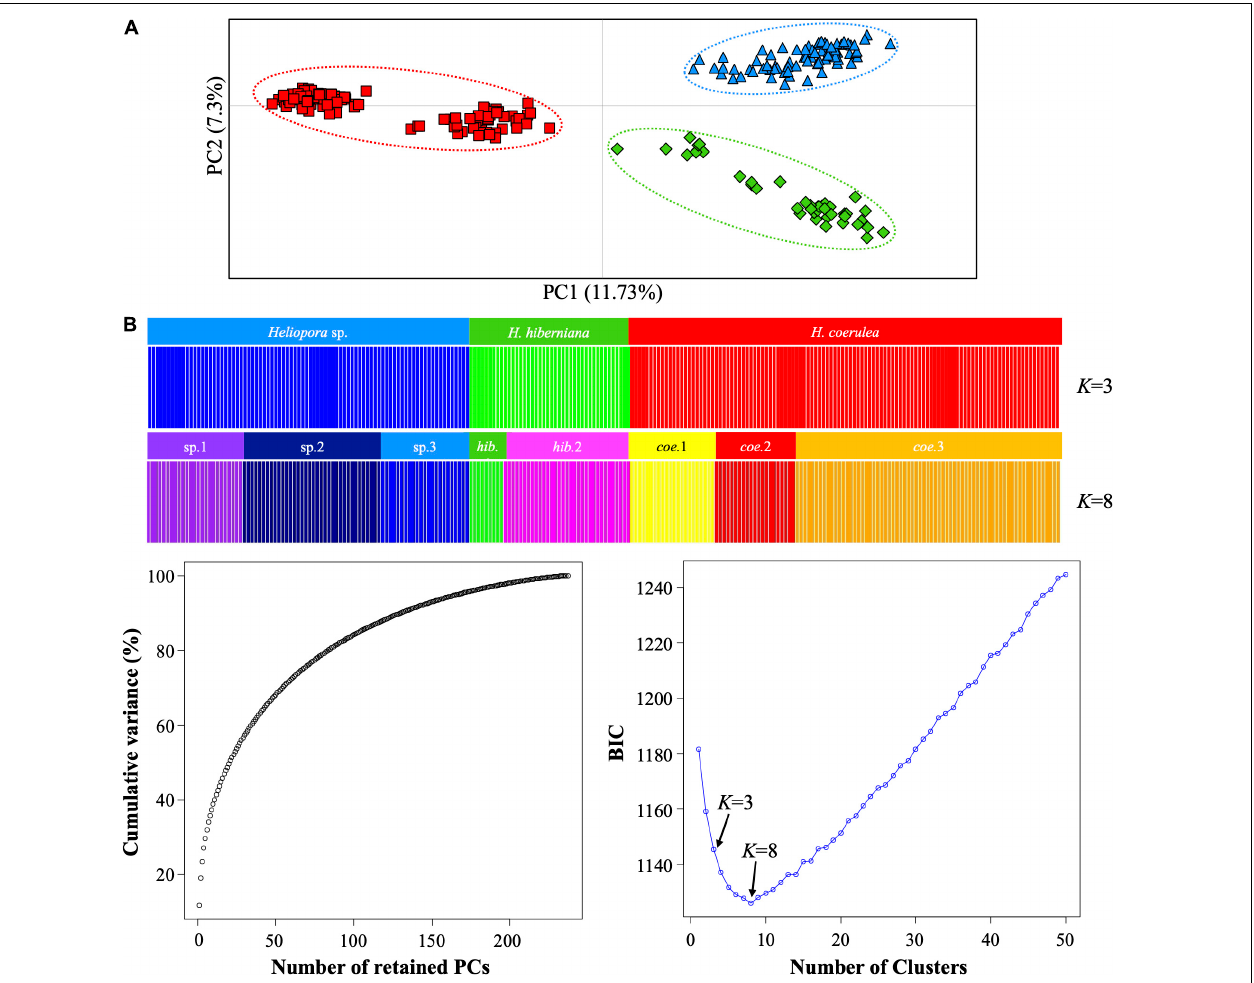
FIGURE 2 | (A) Principal coordinates analysis calculated by GenAlEx v.6.502 using pairwise codominant genotypic distance. Each point represents an individual. (B) Genotype clusters composition plots (above two), and a graph of inference of the number of the PCs and BIC values (below two) of the DAPC. Each bar represents an individual and the colors represent proportional membership coefficients, K = 3 based on 2 PCs and K = 8 based on 7 PCs groups. All the colors used in (A) and (B) correspond with those in the ML tree ( Figure 1 ).